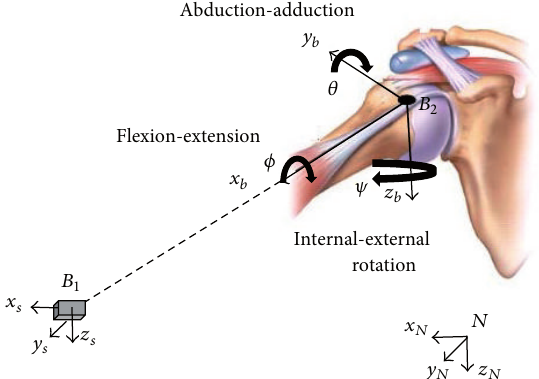
Figure 2: Shoulder region and example of body and inertial coordinate system.